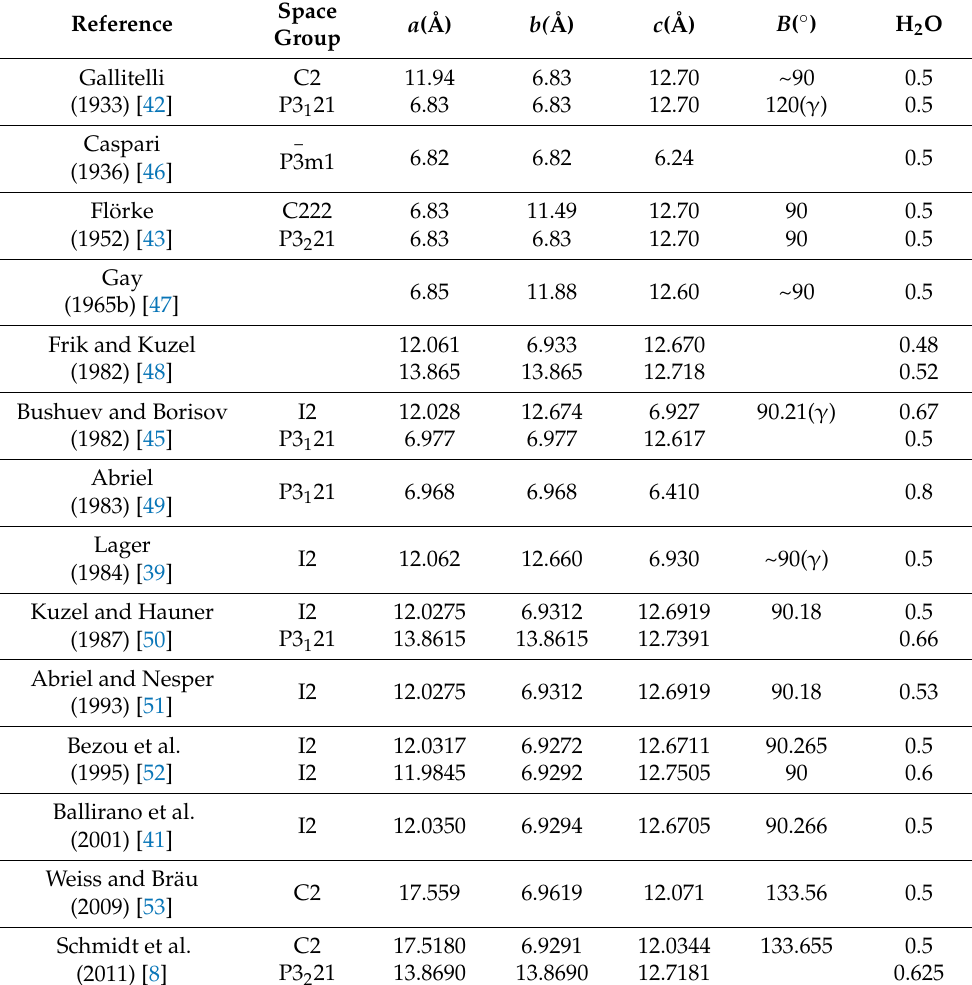
Table 3. Crystallographic data for calcium sulfate hemihydrate (CaSO 4 · x H 2 O, 0.5 ≤ x ≤ 0.8) from the